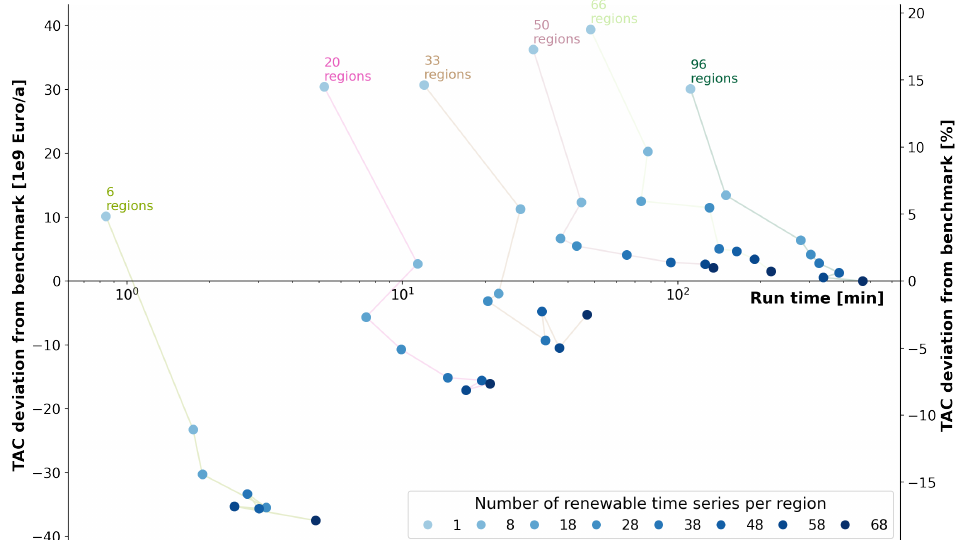
Figure 12. TAC deviation from the benchmark (represented on the y-axis in EUR billion/annum on the left and in % on the right) versus the run time (represented on a logarithmic scale on the x-axis) for each parameter setting. Each dot represents a particular parameter setting. The darker the shade of blue, the greater the number of VRES time series considered, with the lines connecting the dots representing a particular number of